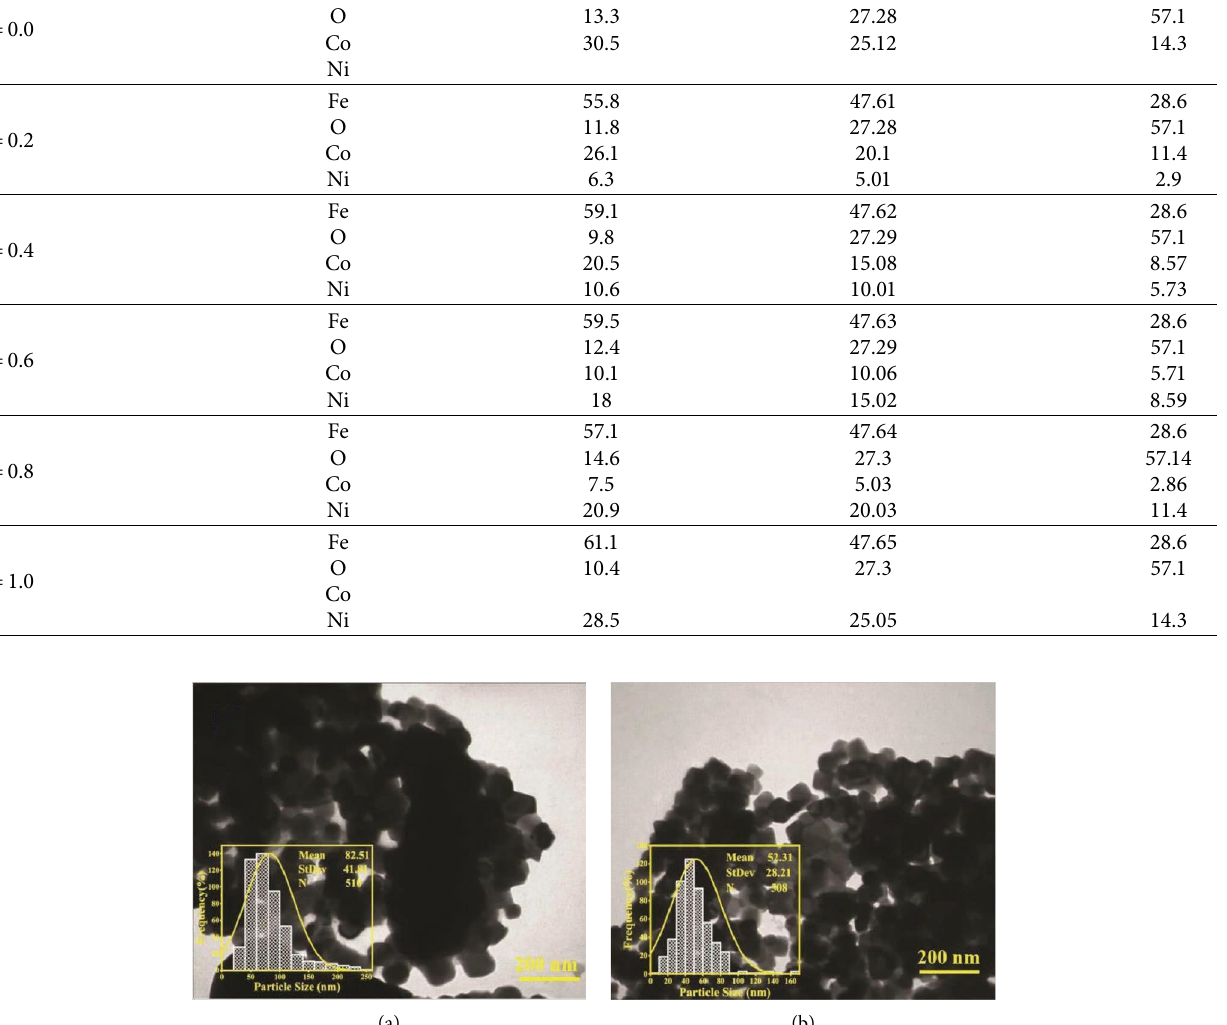
� 0.0 ≤ x ≤ 1.0) 1 − x Ni x Fe 2 O 4 (where x Wt. (%) Teoretical